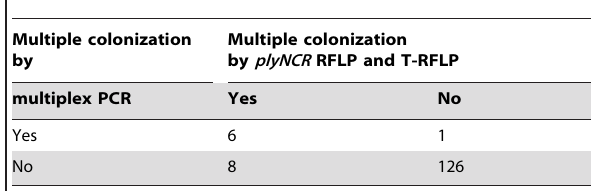
Table 3. Comparison between multiplex PCR and plyNCR RFLP/T-RFLP for the detection of multiple colonization in 141 nasopharyngeal swabs collected during study period 4 for which culture revealed growth of a pneumococcal strain.